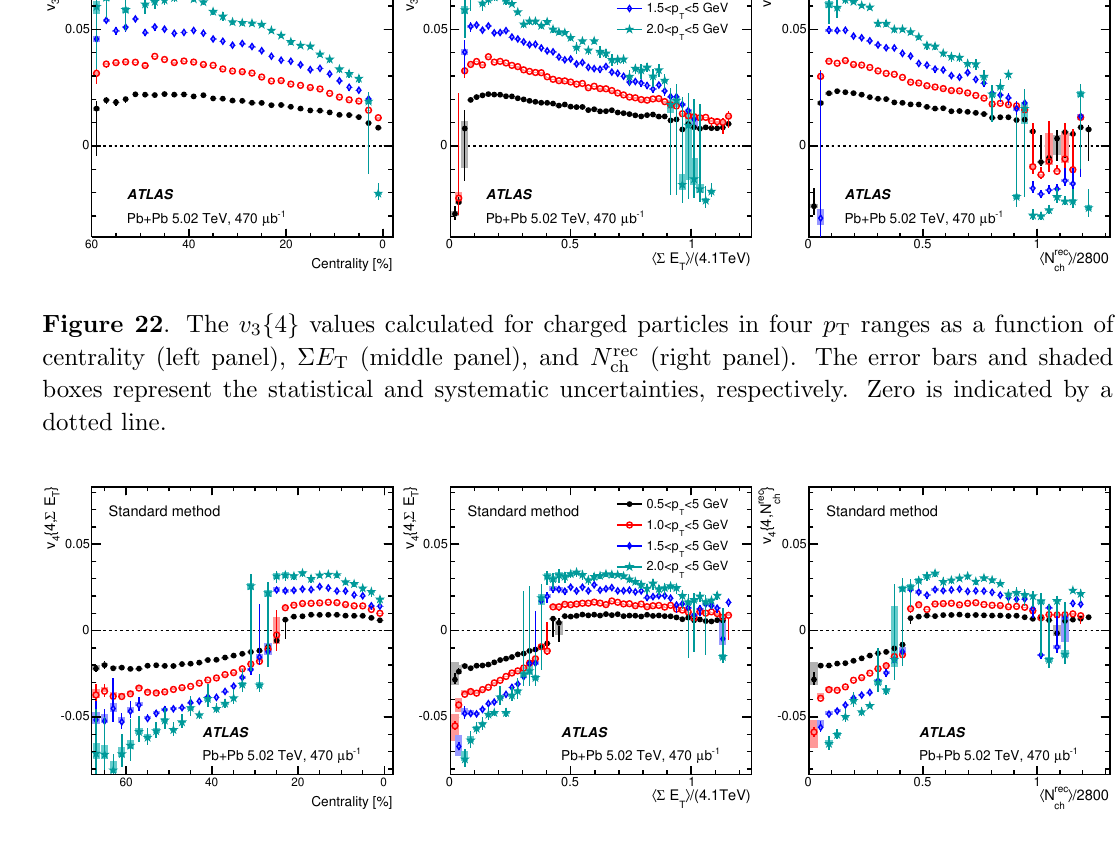
(right panel). The error bars and shaded ch